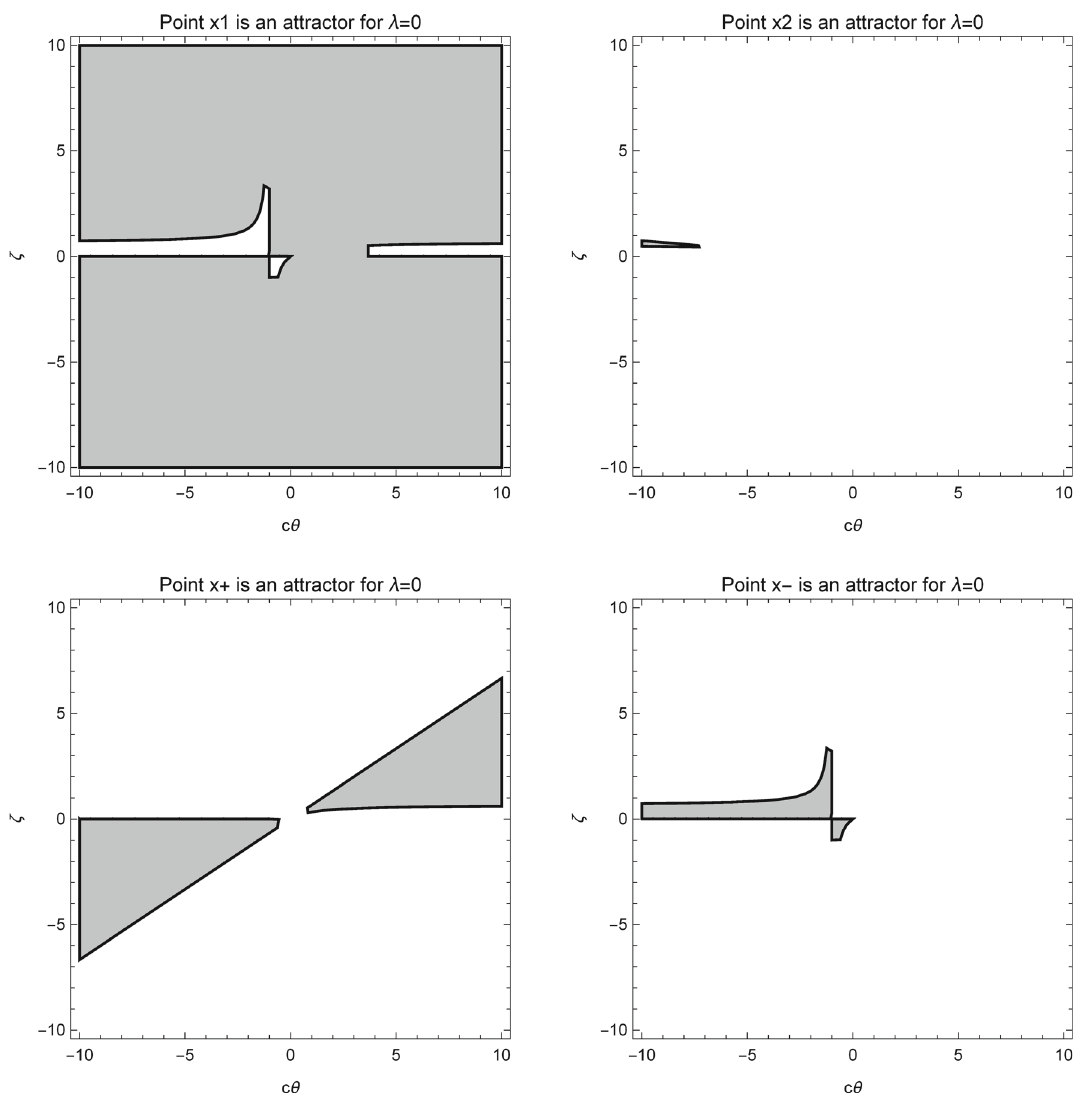
Fig. 8 Region plots in the space of parameters { c θ ,ζ } , where the stationary points x ± , x 1 and x 2 are attractors, for λ = 0 . Point x 0 always describes an unstable